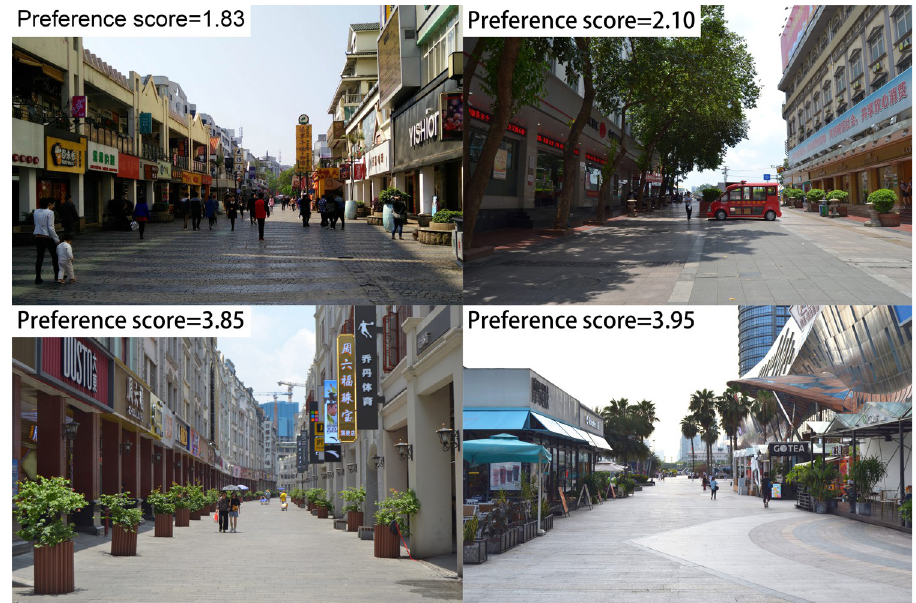
Fig 1. The photographs with the lowest preference scores and highest preference scores.